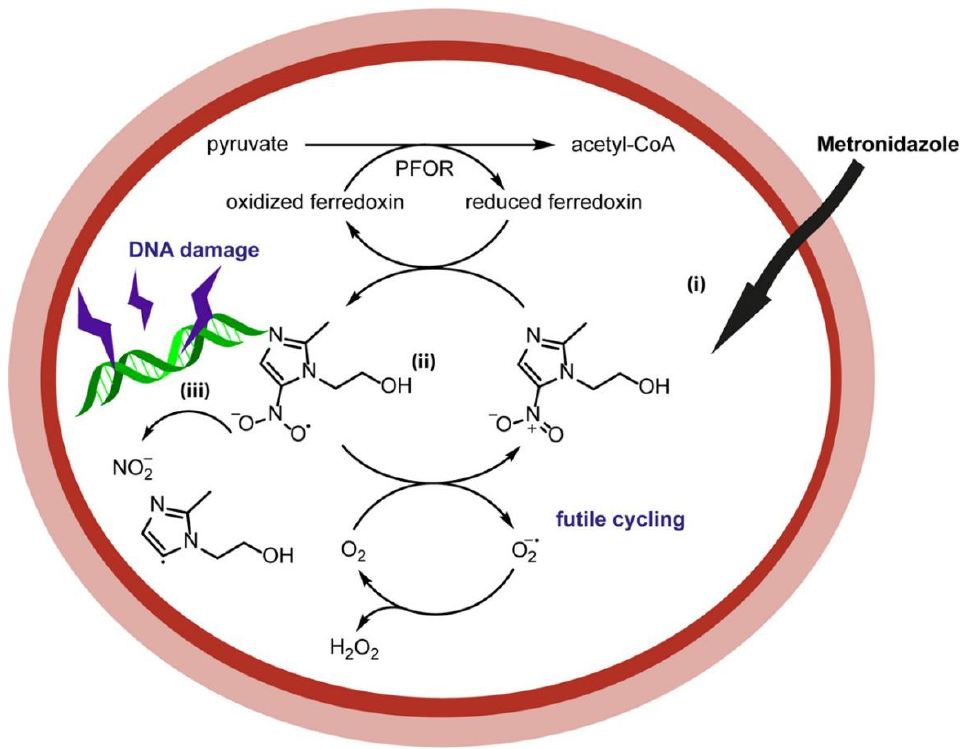
Figure 3. Mechanism of metronidazole [27] involving bioreduction of the nitro group by ferredoxin. Resistance to MTZ in cases of H. pylori is more common than with other antimicrobials and can be as high as 80%, depending on the patient group and geographic region